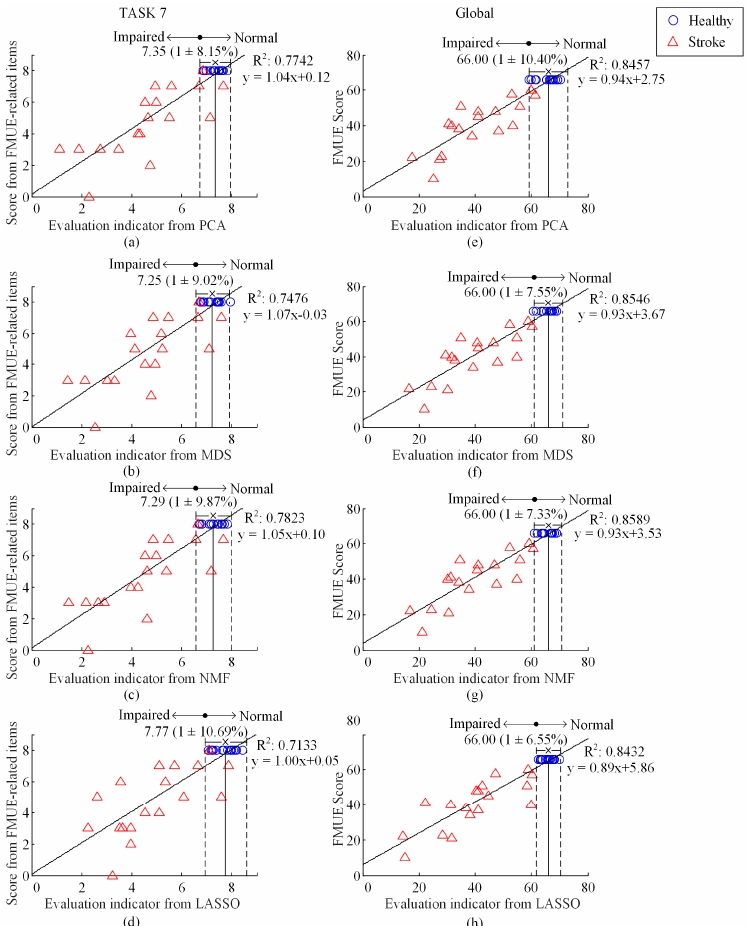
Figure 7. Plot of score of FMUE-related items versus the EI for TASK 7 ( a – d ), and plot of FMUE score versus the EI ( e – h ), using PCA ( a , e ), MDS ( b , f ), NMF ( c , g ), and LASSO ( d , h ), respectively. All symbols and lines appear in the same way as illustrated in Figure 5.